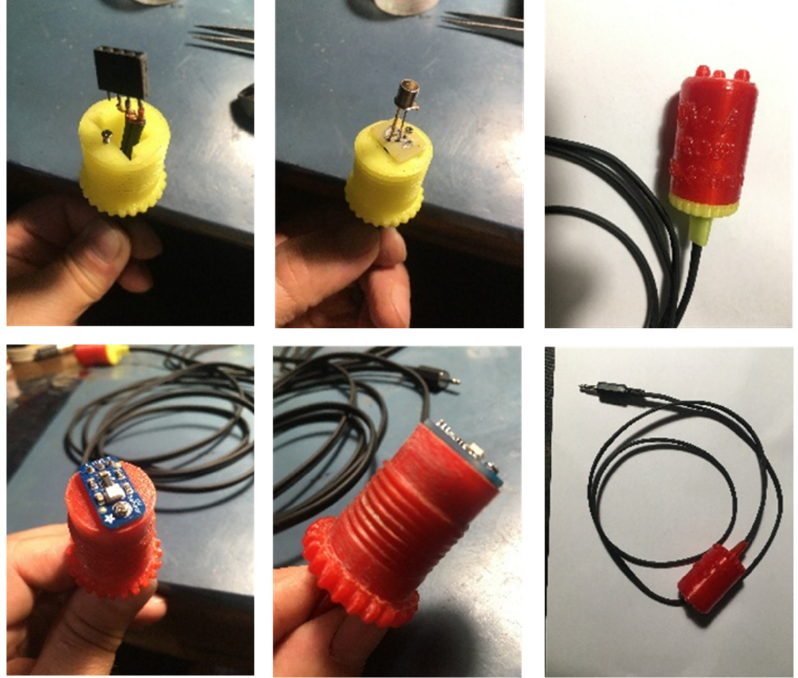
Figure 5. UV sensor probes mounted on 3D-printed enclosures and wired up for Arduino connection.